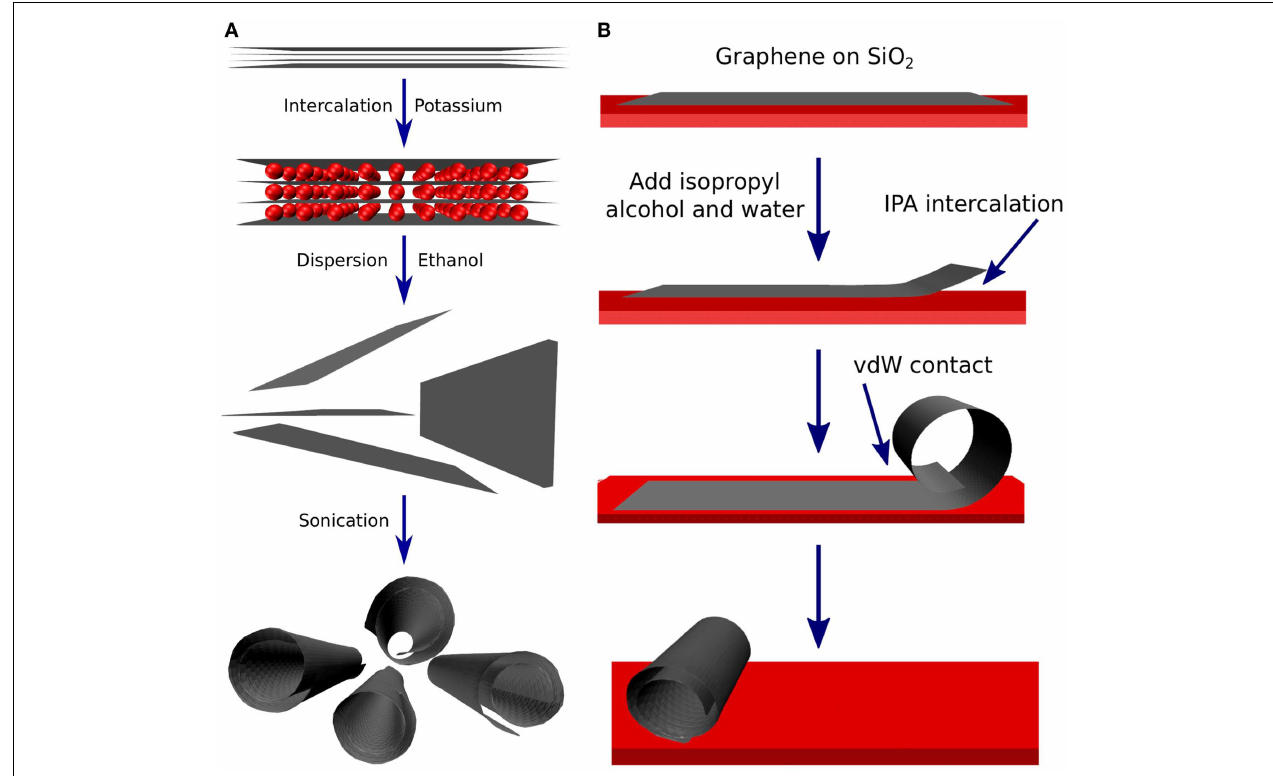
exfoliated from graphite and deposited on SiO 2 .Then a droplet of isopropyl alcohol (IPA) and water is placed on the monolayer and evaporated. Both methods lead to well-formed